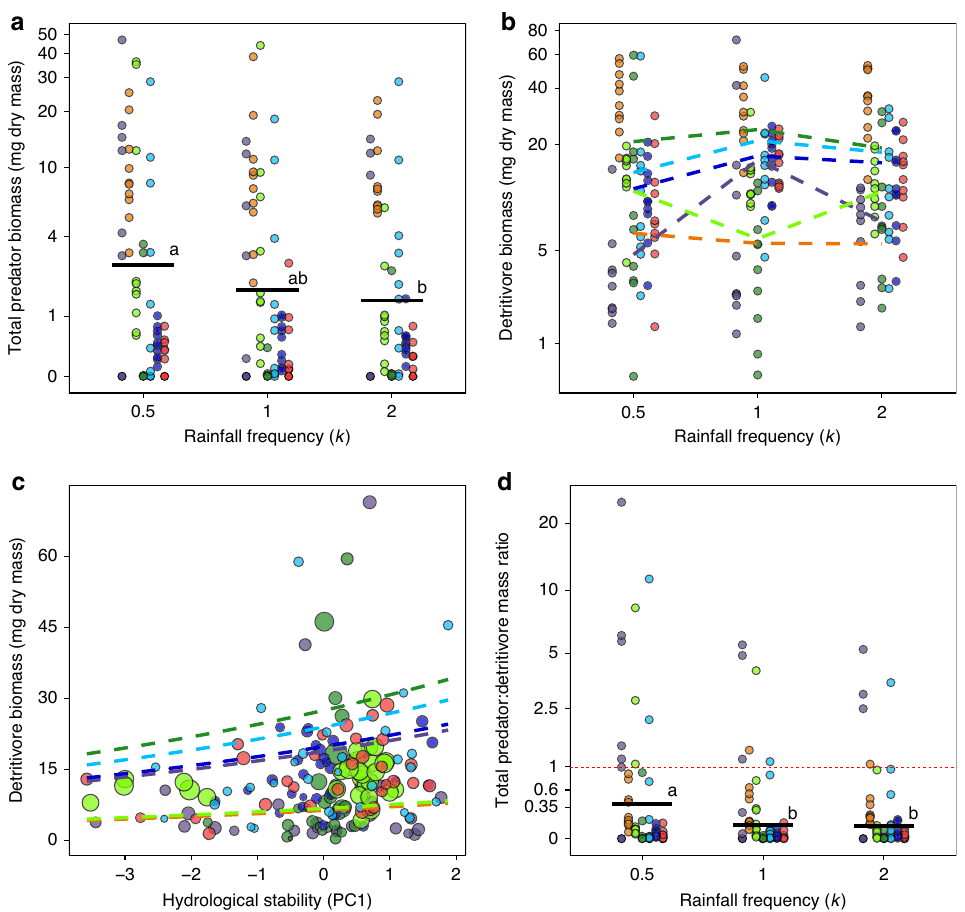
Fig. 2 Standing stock of predators and detritivores, and pyramid shape, change under rainfall frequency and hydrological stability. In fl uence of rainfall frequency ( k ) on a total predator standing stock (top + mesopredators), b detritivore standing stock, and d total predator:detritivore mass ratio (PDMR; pyramid shape). Detritivore biomass was also in fl uenced by habitat size and hydrology ( c ). Horizontal bars a , d denote mean values; different letters indicate statistically signi fi cant differences (Tukey contrasts, α = 0.05). In c , habitat size (bromeliad volume) is represented by circles of varying sizes. In d , PDMR > 1 (threshold in red dashed line) indicates bromeliads with inverted trophic pyramids. k equals to 1 represents typical average values of rainfall frequency; values lower and higher than 1 represent deviance from typical values, and characterize extreme events. Circle colors indicate sites of the experiment; colors match with the sites plotted in Fig. 1a. Jitter function was used to add random noise to data in order to prevent